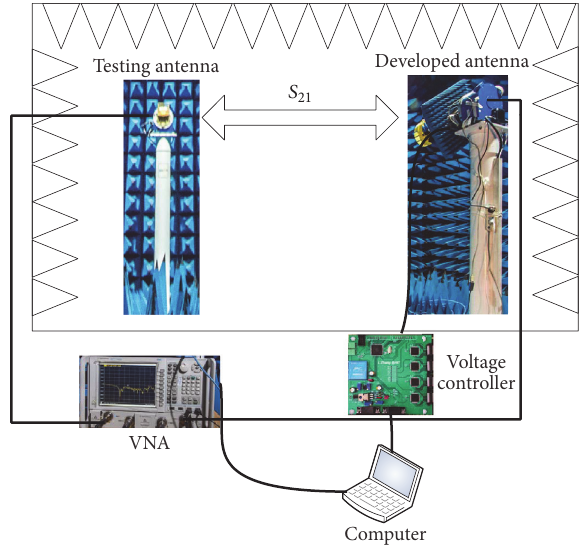
Figure 9: Illustration of the genetic algorithm based platform.